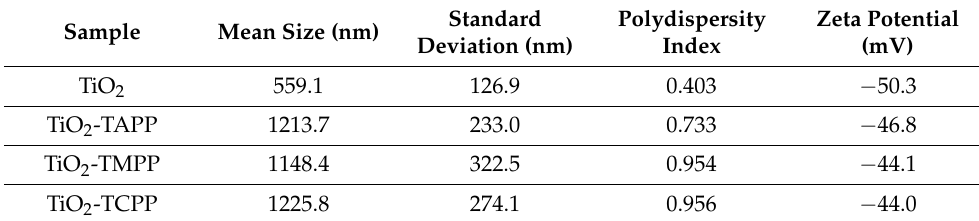
Table 2. The mean hydrodynamic size and zeta potential of the